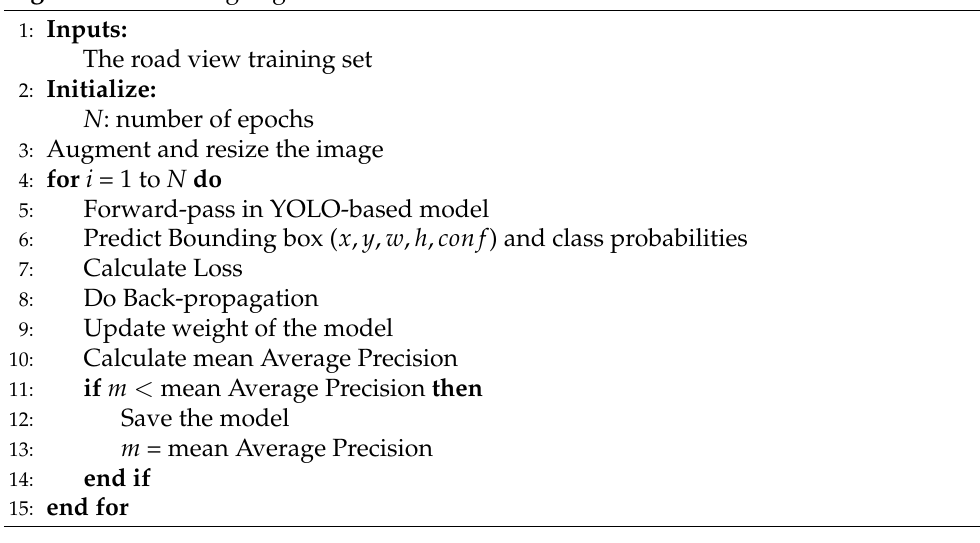
Algorithm 1 Training Algorithm.